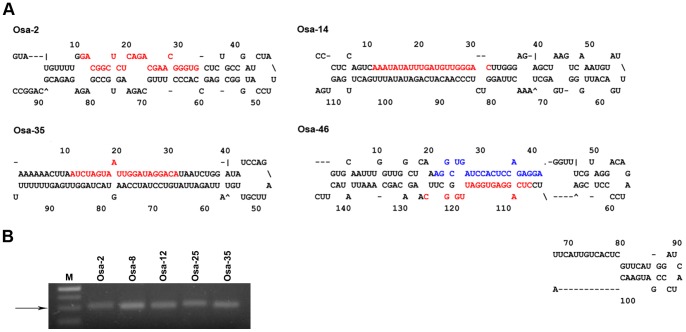
Predicted novel miRNAs identified in this study.(A) Predicted stem-loop structures of novel miRNA precursors. The precursor structures of four newly identified rice miRNAs (Osa-2, Osa-14, Osa-35 and Osa-46) were predicted via the MFOLD pipeline. Mature miRNA and miRNA* sequences are highlighted in red and blue, respectively. The numbers along the structure indicate nucleotide sites from the 5′ end of the pre-miRNAs sequence. (B) Stem-loop RT-PCR analysis if the identified novel miRNAs. Five novel miRNAs were confirmed via stem-loop RT-PCR. The sizes of the obtained PCR products were approximately ∼60 bp. M indicates a 20 bp DNA Ladder Marker (Takara, Japan). The arrow indicates 60 bp.